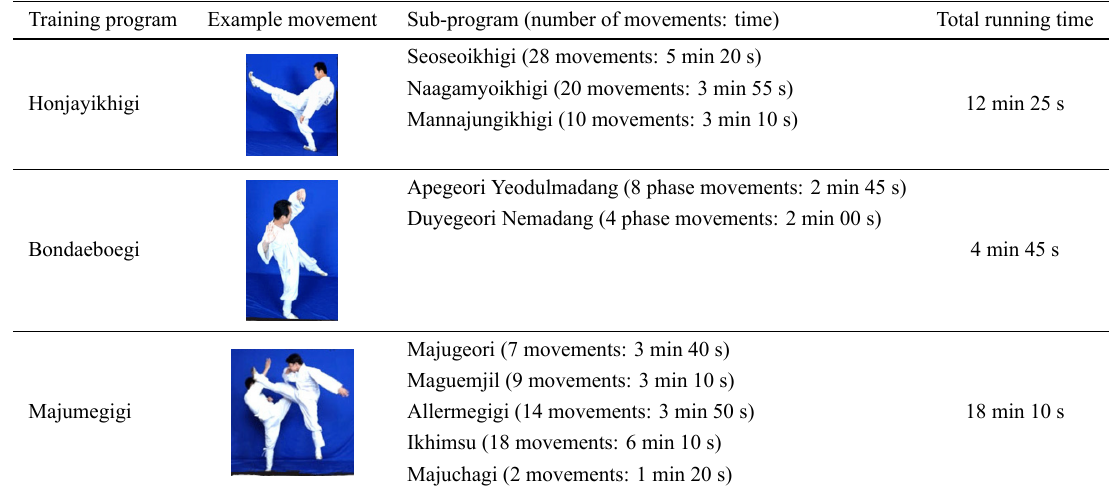
Table 2. Taekkyeon program.